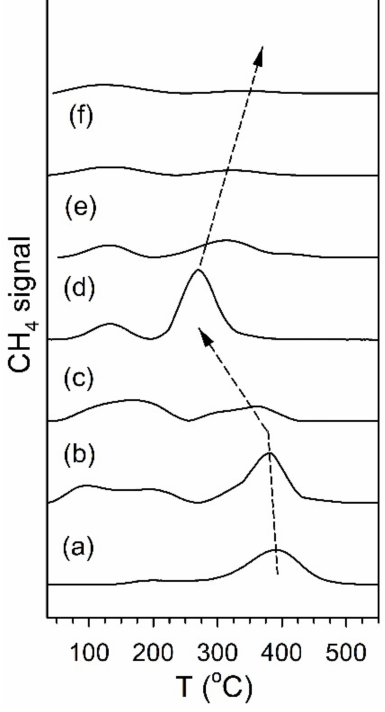
Figure 12. TPD-MS of ethanol steam reforming over (a) 2% Pt/ZrO 2 , (b) 0.85% K-2% Pt/ZrO 2 , (c) 1.70% K-2% Pt/ZrO 2 , (d) 2.55% K-2% Pt/ZrO 2 , (e) 3.40% K-2% Pt/ZrO 2 , (f) 4.25% K-2% Pt/ZrO 2 , and (g) 8.50% K-2% Pt/ZrO 2.